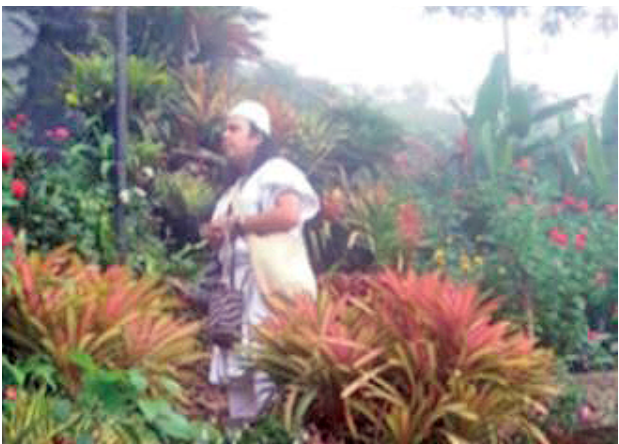
Figure 8. One of the Arhuaco community’s Mamos. Photo donated by Kasokaku Busintana Mestre